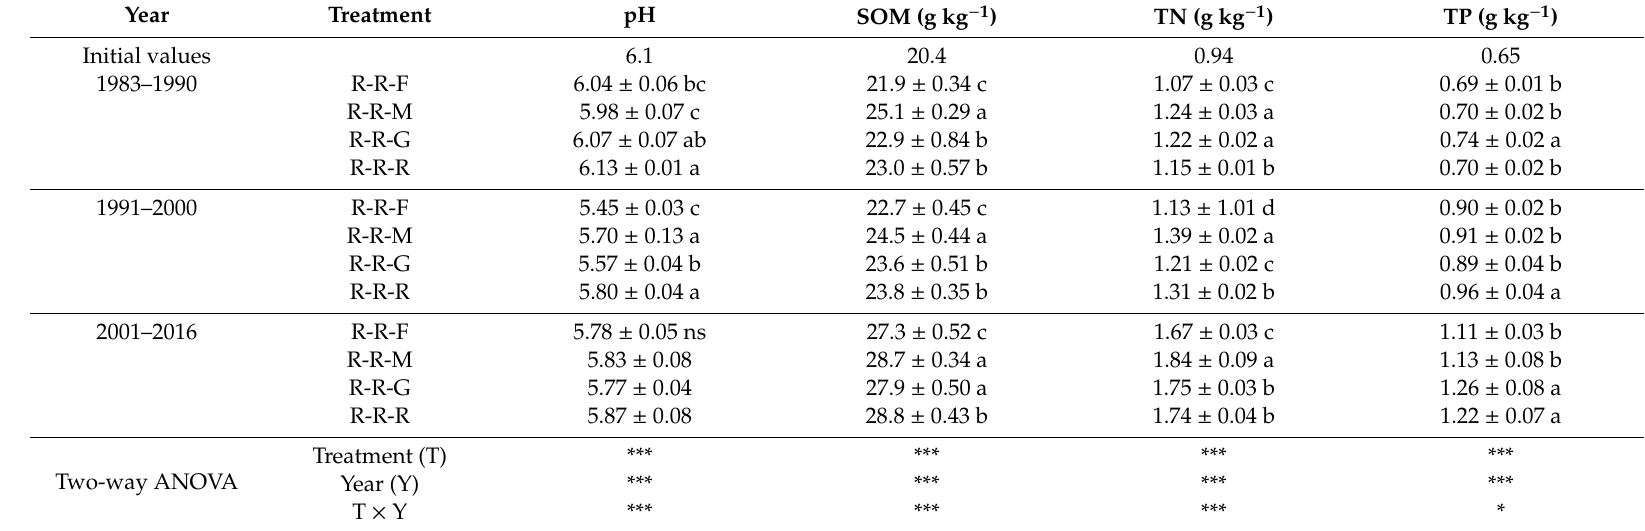
Table 2. E ff ect of long-term green manure rotations on soil pH, soil organic matter (SOM), total nitrogen, and total phosphorus content in acidic paddy